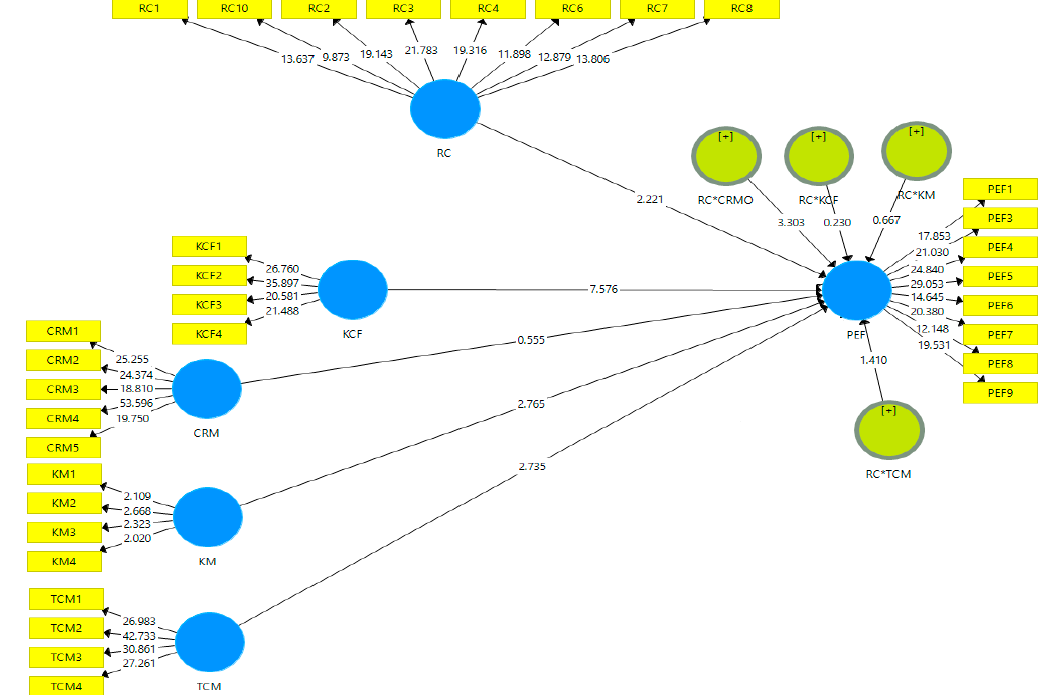
Figure 4. The relational capital moderation algorithm. Table 6. The structural model (moderating effects).